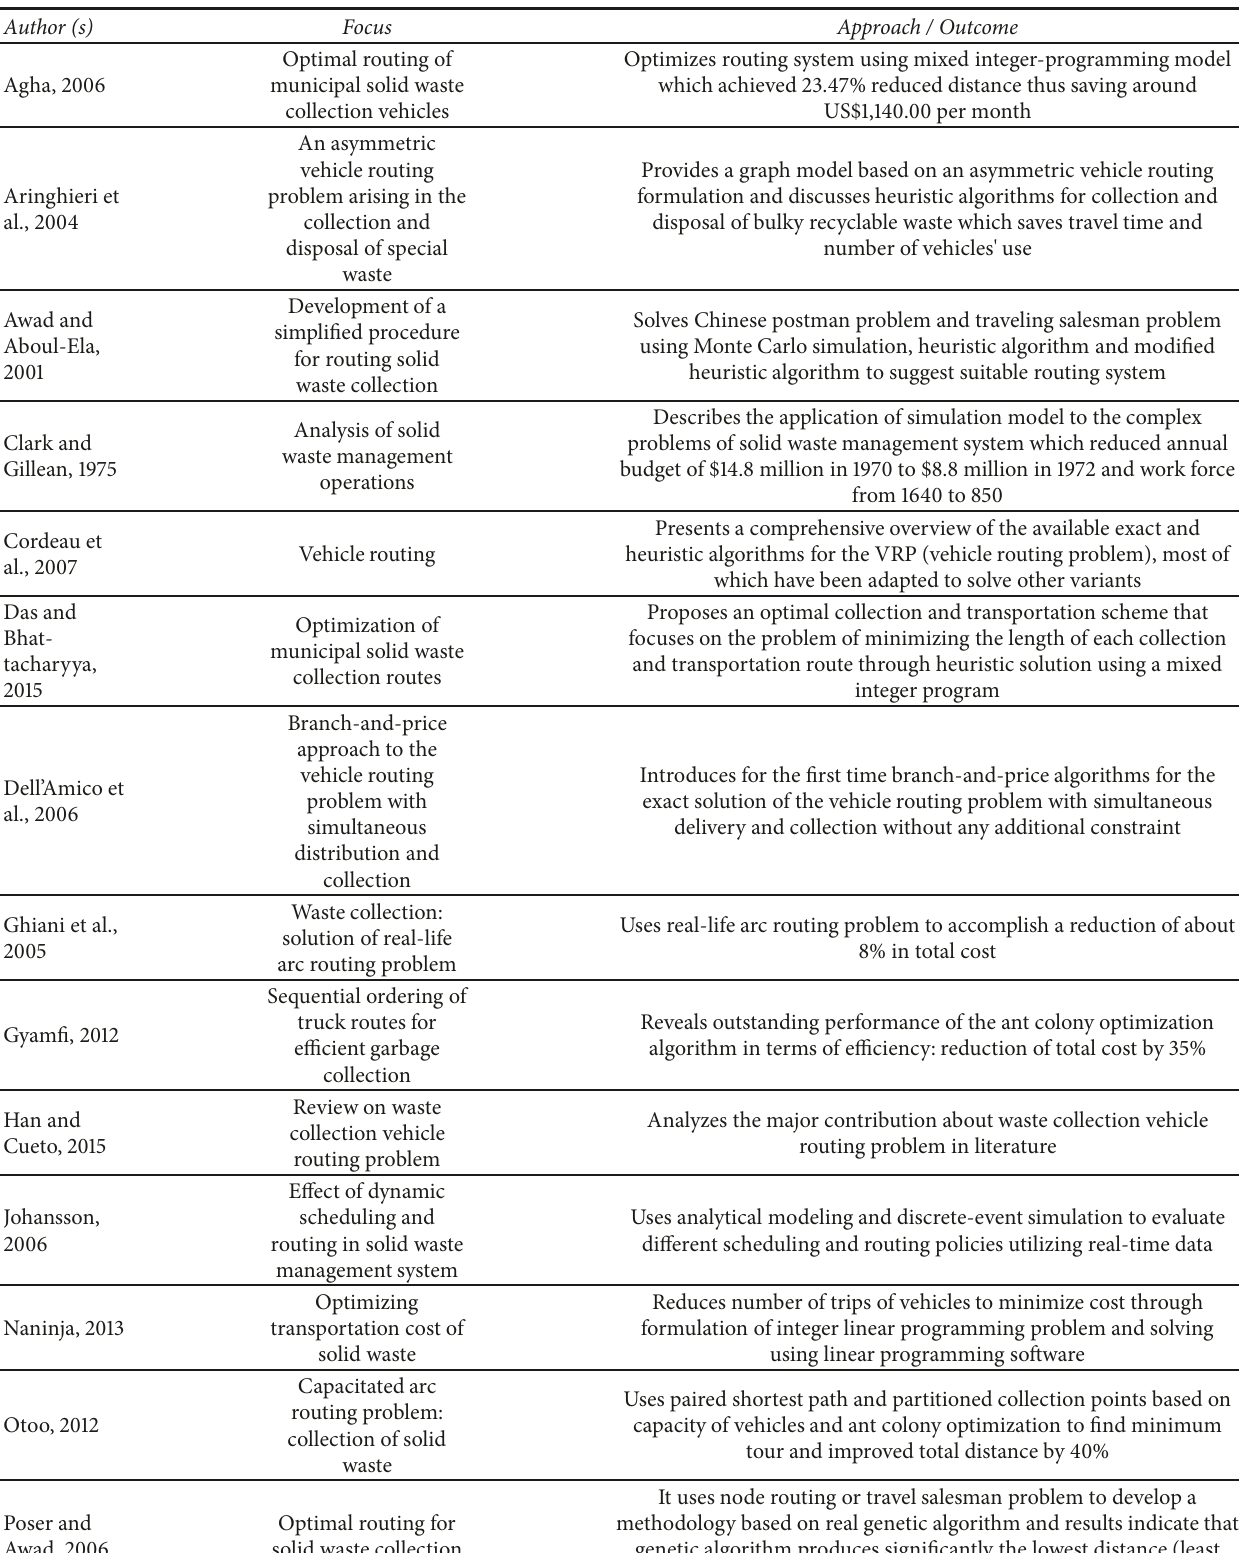
Table 1: Studies on routing using mathematical programming approaches (nonexhaustive